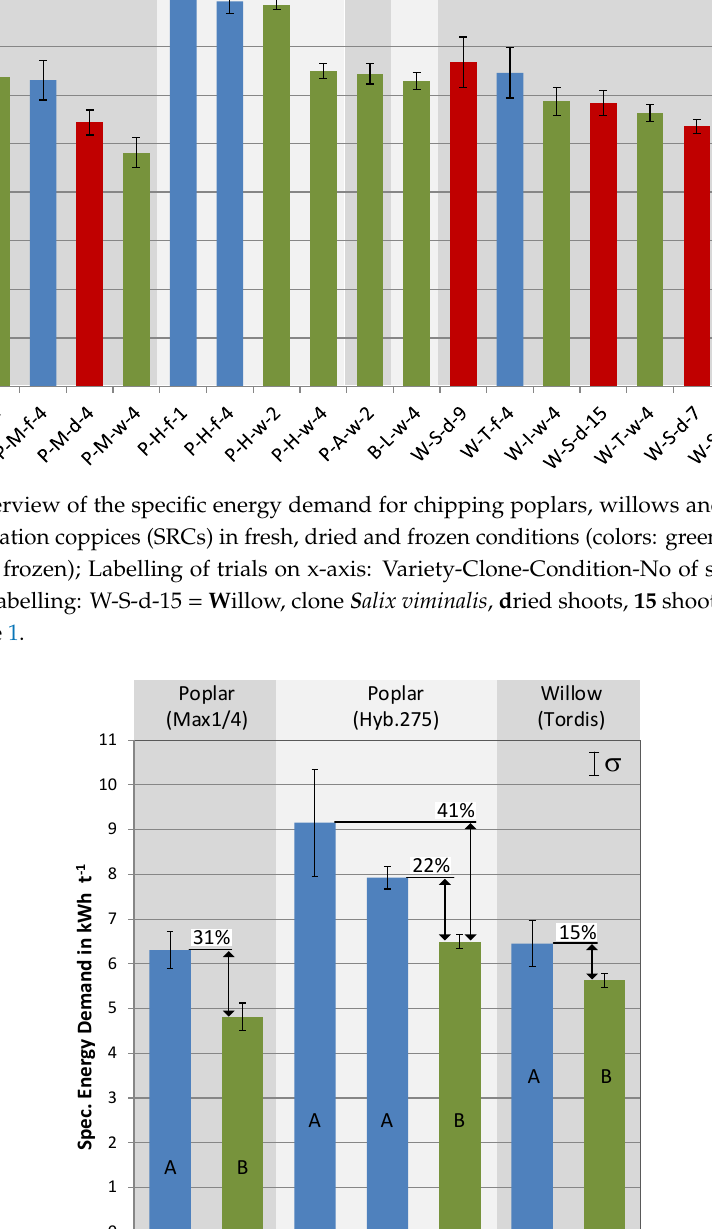
Figure 7. Comparison of the specific energy demand for chipping fresh and frozen poplars and willows from SRCs (colors: green = fresh, blue = frozen; different letters indicate significant differences between trials ( p ≤ 0.05)); Labelling of trials on x-axis: see Table 1.